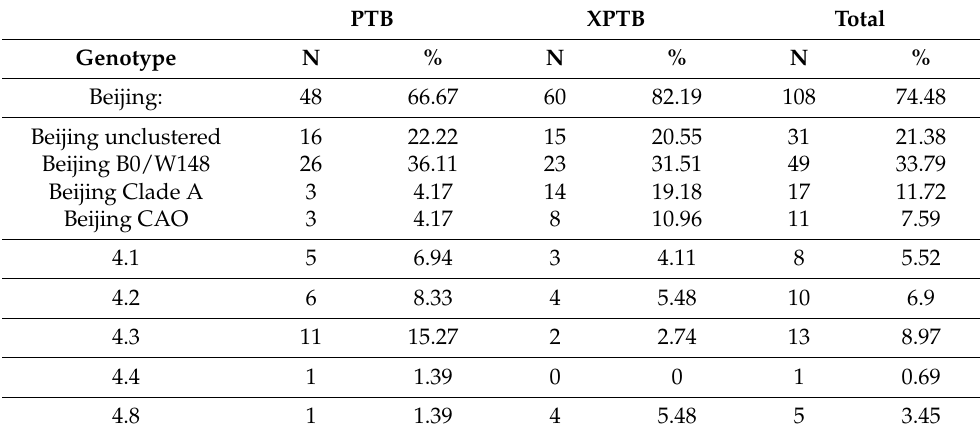
Table 1. Genetic clades, identified among M. tuberculosis isolates from different localizations. PTB XPTB